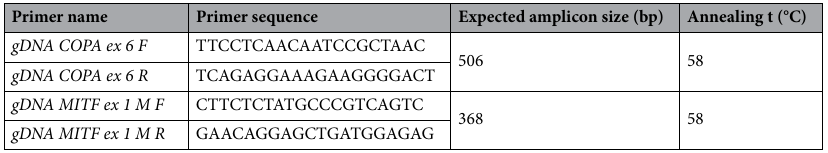
Table 3. Primer sequences used for cDNA and gDNA